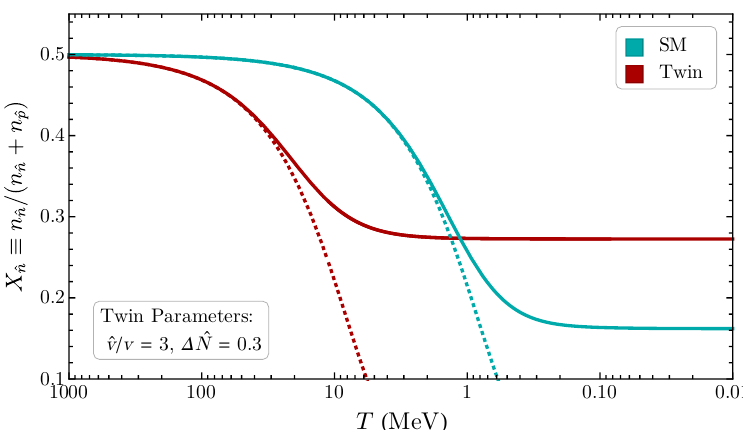
Figure 2. An example of the evolution of the twin neutron fraction X ˆ n (solid red line) as a function of temperature showing twin neutron freeze-out. Also shown is the evolution of the SM neutron fraction X (solid teal line). The dotted lines indicate the equilibrium values of the neutron fraction n for the two